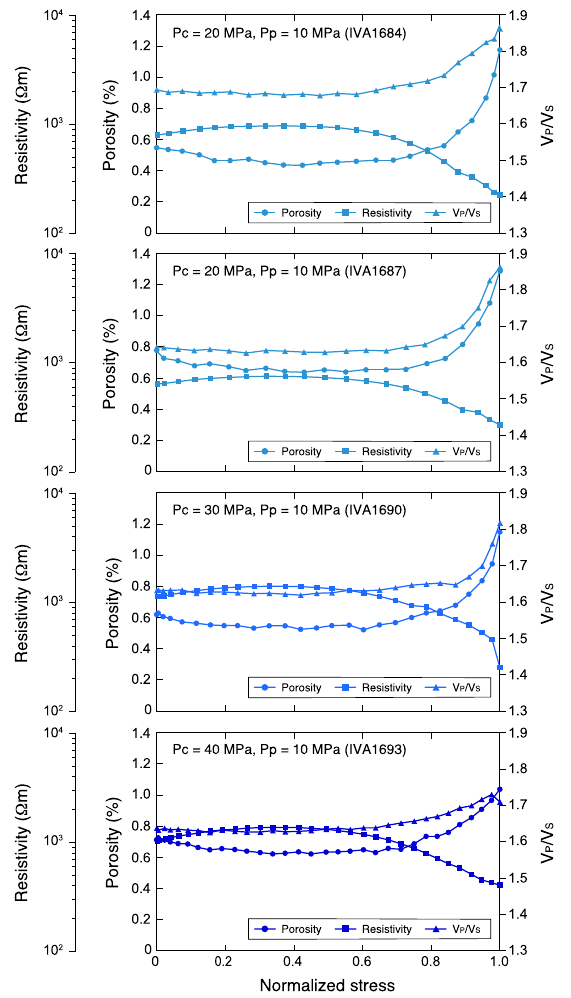
Fig. 4 Electrical resistivity, porosity, and V P / V S changes as a function of stress, which are normalized to the maximum stress during the deformation of each sample